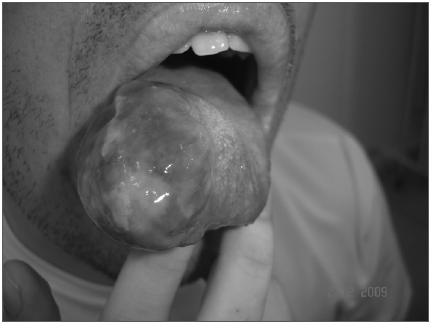
Figura 1. Massa tumoral em borda lingual